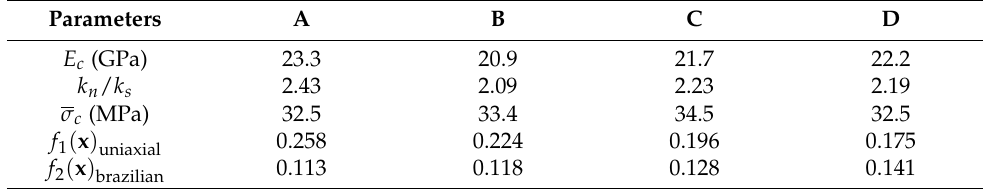
Table 6. Verification results for parameter identification.